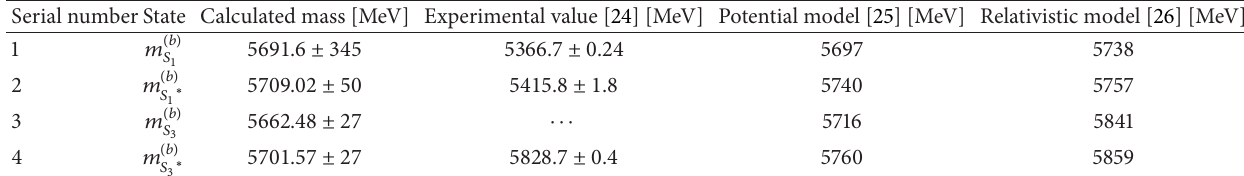
Table 1: Calculated masses of excited 𝐵 mesons compared with experimental values, potential model, and relativistic